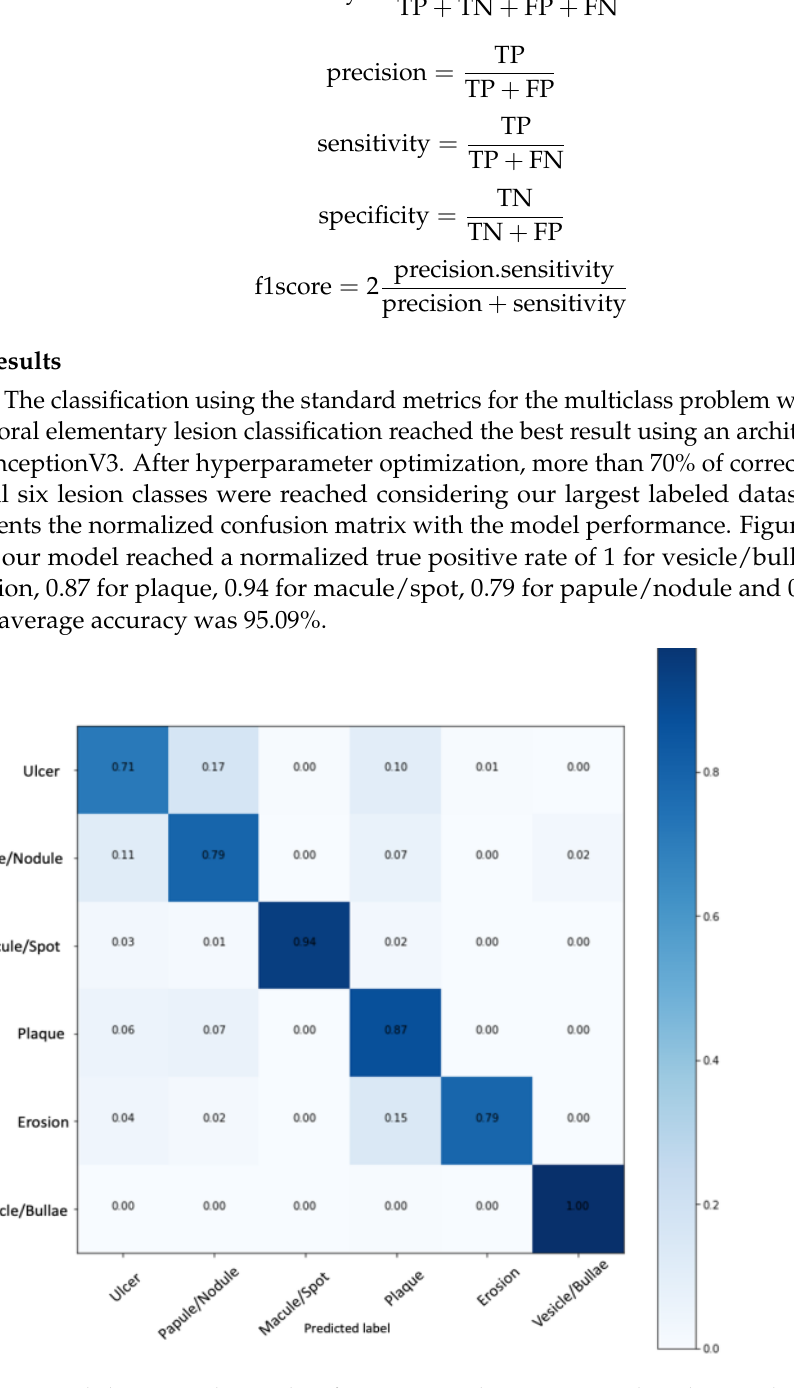
Figure 5. Oral elementary lesion classification using the InceptionV3-based network.